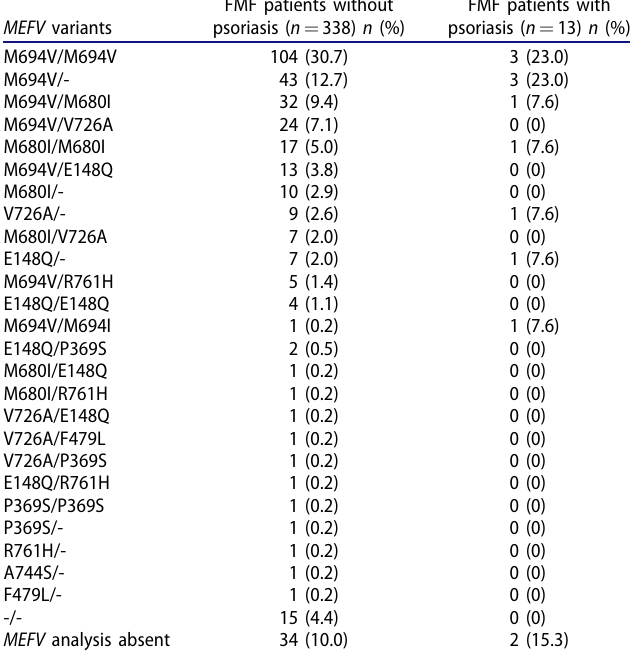
Table 3. The MEFV variants in familial Mediterranean fever (FMF) patients with and without psoriasis. MEFV